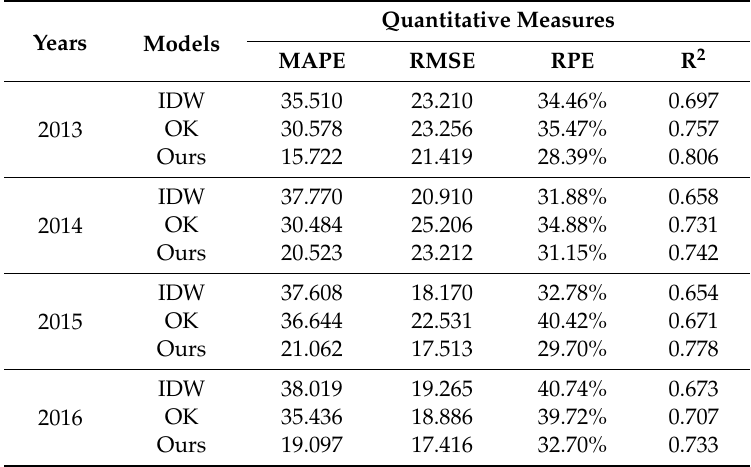
Table 4. Geospatial prediction models